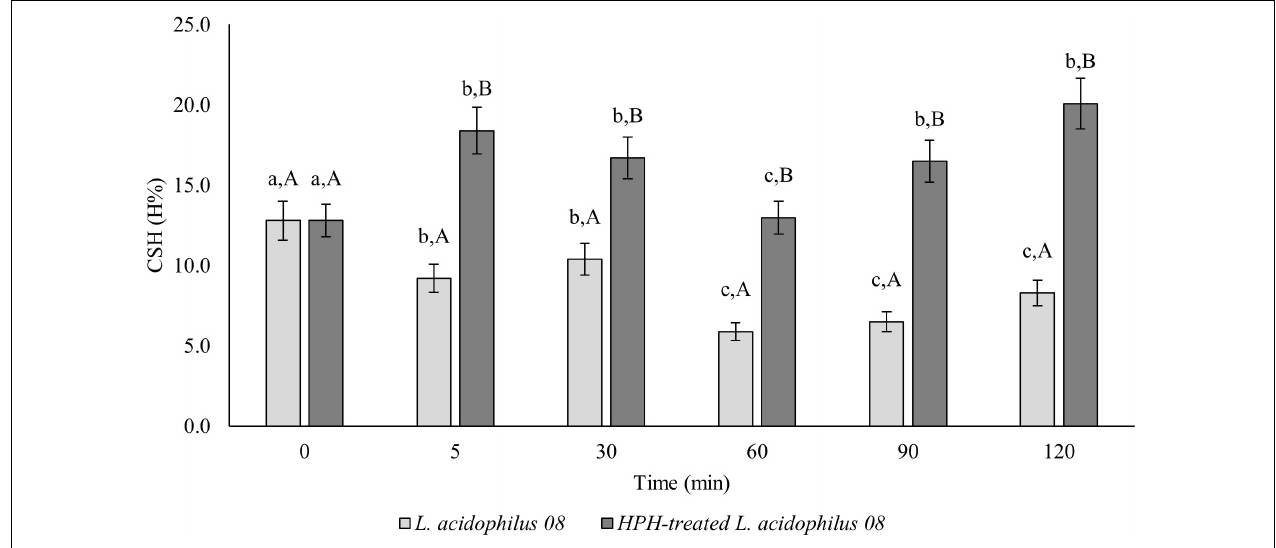
FIGURE 1 | Lactobacillus acidophilus 08 cell surface hydrophobicity (CSH) (H%) of the untreated ( L. acidophilus 08) and treated cells at 50 MPa (HPH-treated L. acidophilus 08). The results are the average of three independent replicates ( n = 3). Error bars indicate the SD. Among the series, different letters indicate the samples that are significantly different ( p < 0.05). Different lowercase letters indicate the significant differences for a considered sample during the frame time considered (0–120 min), while capital letters indicate the significant differences at the considered time differences between samples (untreated control and treated).